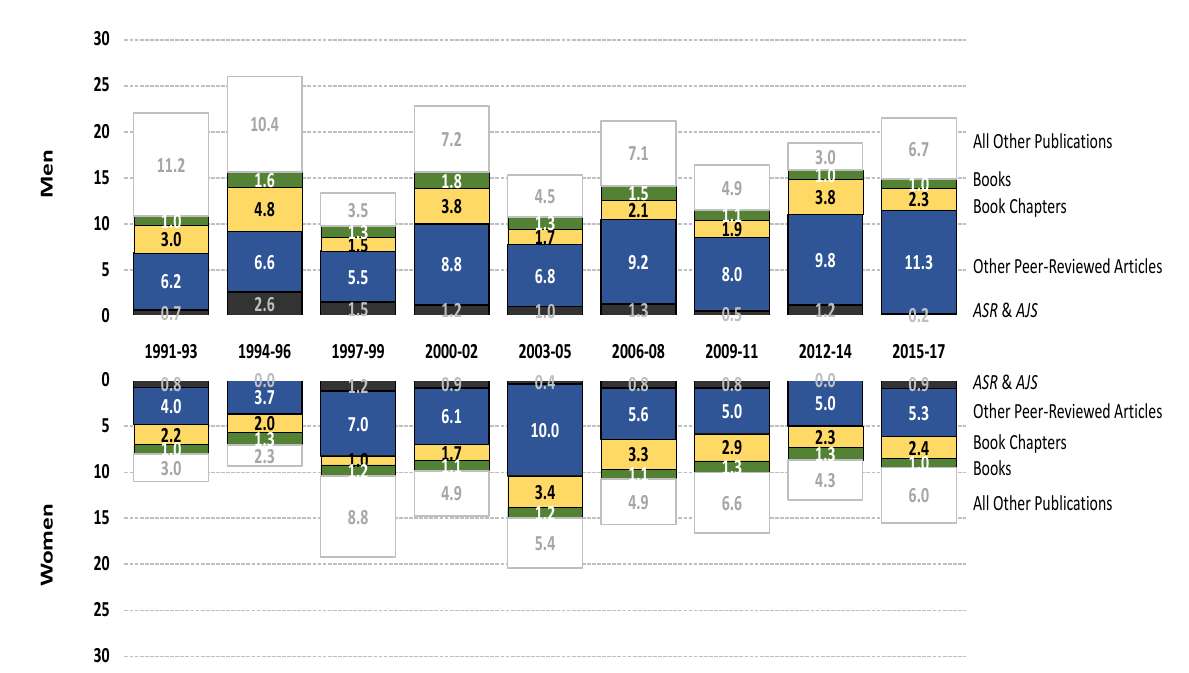
Figure 15: Mean number of publications for newly promoted associate professors who published at least one book by type, year, and